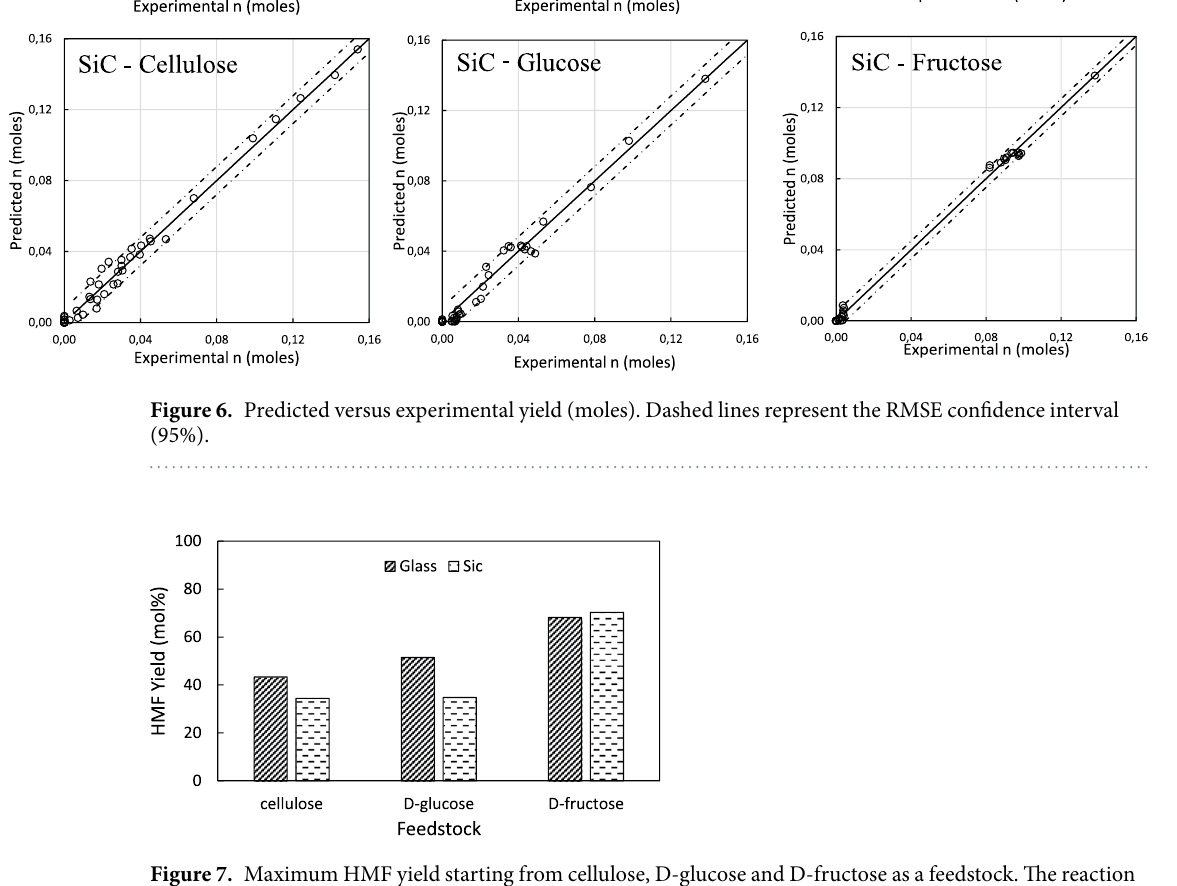
Figure 7. Maximum HMF yield starting from cellulose, D-glucose and D-fructose as a feedstock. The reaction time where maximum HMF is achieved, is depicted above the bar plot. Conditions: T = 177 °C, c HCl = 0.046 M, stirring rate = 800 RPM, reactor content: 25 mg feedstock and 5 mL reaction medium (250 μ L acidified water and 4.75 mL